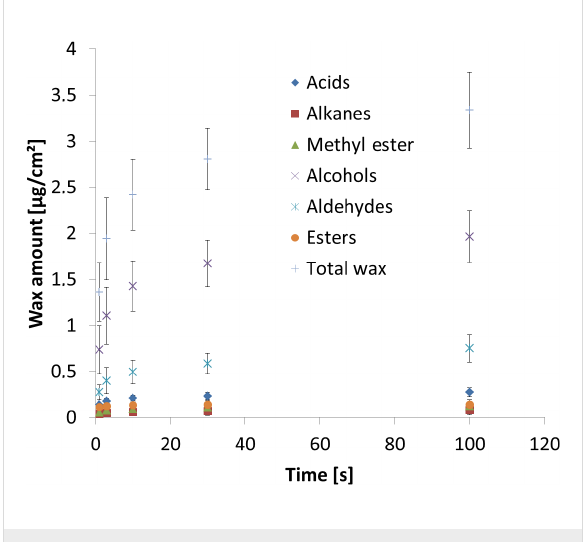
Figure 2: Extraction kinetics of soybean leaf wax by repetition of chloroform dipping. Absolute amounts [µg/cm²] extracted are plotted versus the total dipping times (1, 3, 10, 30, and 100 s) and extracted masses. Fraction 3 (10 s) represents the wax composition of a leaf which was dipped first for 1 s (fraction 1), than again for 2 s (fraction 2), and again for 7 s (fraction 3) in CHCl 3 . Each fraction was analyzed separately. Data points represent the mean ( n = 4) ± stan- dard